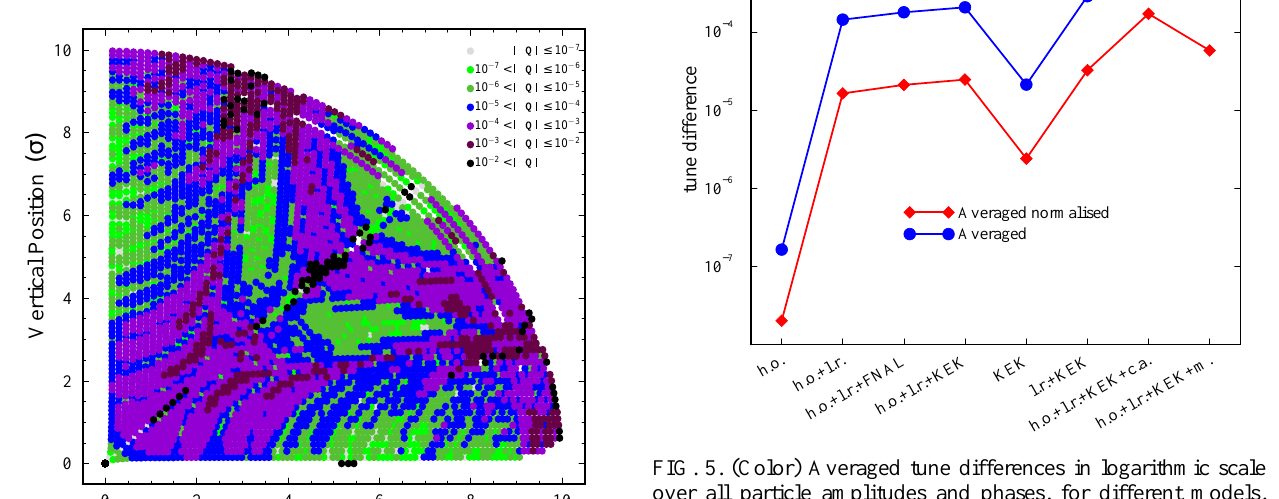
FIG. 5. (Color) Averaged tune differences in logarithmic scale over all particle amplitudes and phases, for different models. The blue curve corresponds to a simple average of the tune change over all tracked particles and the red one to a normalized average by dividing the tune variation of every particle with its initial